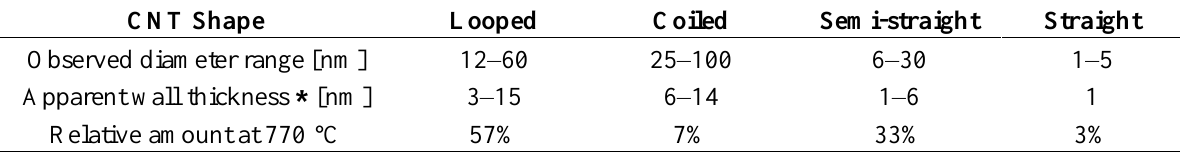
Table 1. Classifications of CNTs in groups based on their fundamental